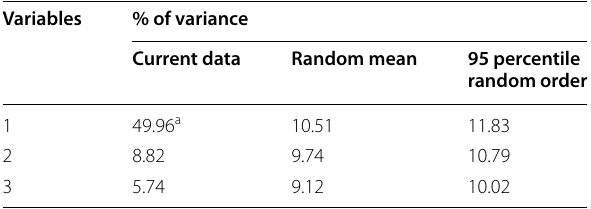
Table 5 Parallel analysis based on minimum rank factor analysis (MRFA)